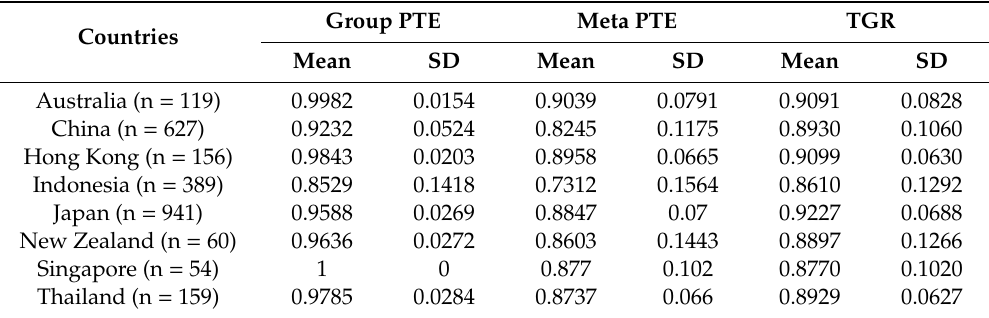
Table 7. Group-frontier PTE, Meta-frontier PTE, and TGRs for Sample Countries (2005 to 2014).